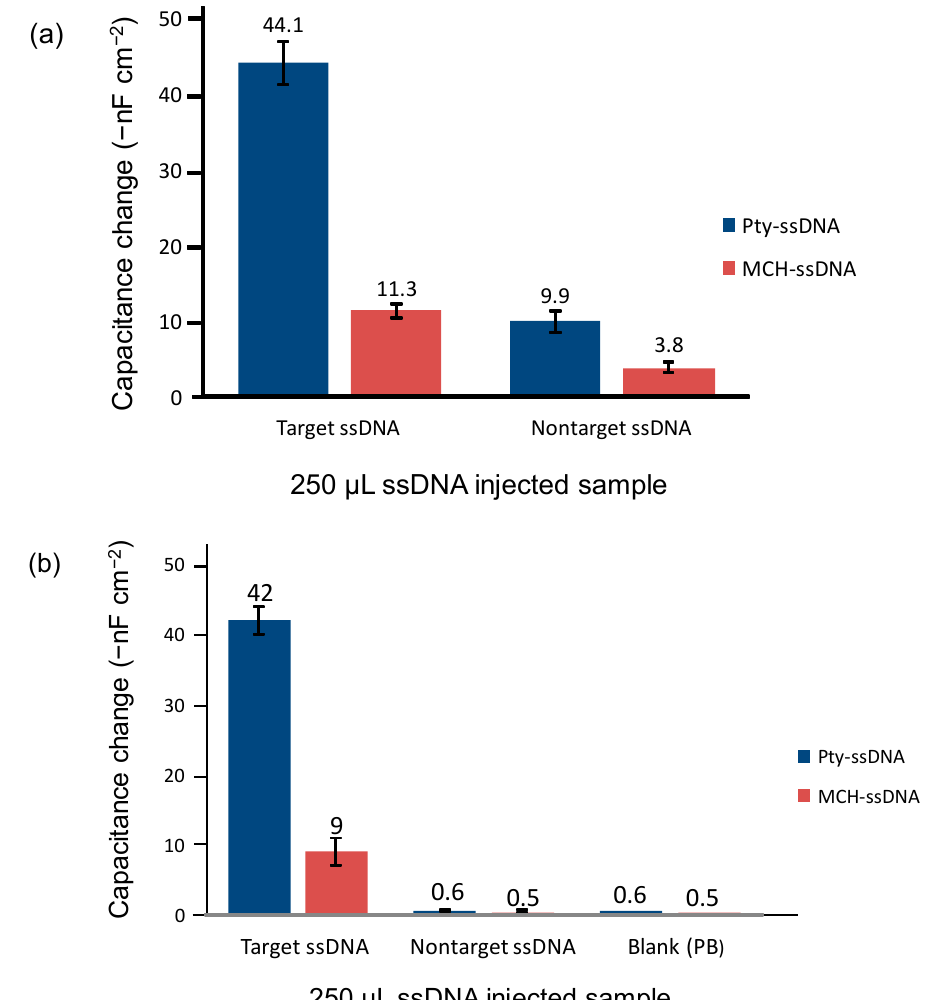
Figure 7. The amplitude of responses from Pty-ssDNA and MCH-ssDNA sensor chips to injection of equimolar concentrations, 10 − 8 M, of target and non-target ssDNA samples at ( a ) 23 °C (RT) and ( b ) 50 °C hybridization temperatures, respectively.